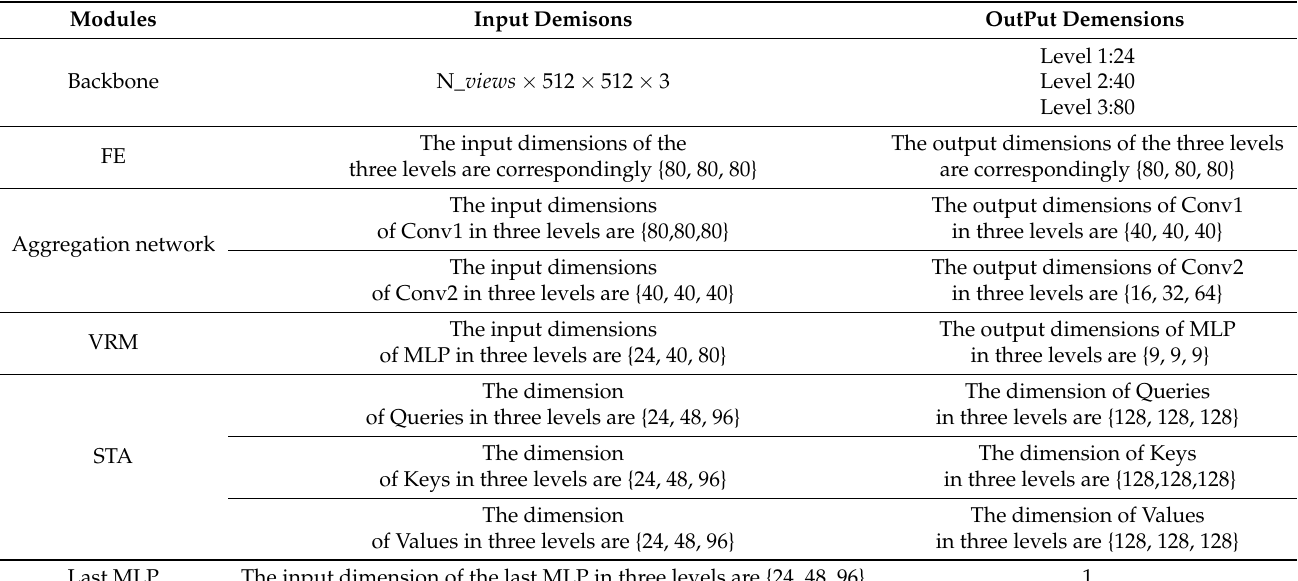
Table 1. The input dimension and output dimension of main